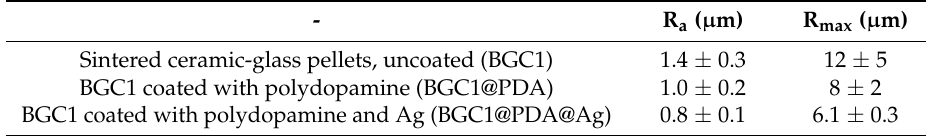
Table 1. Roughness measurements of the different samples investigated.